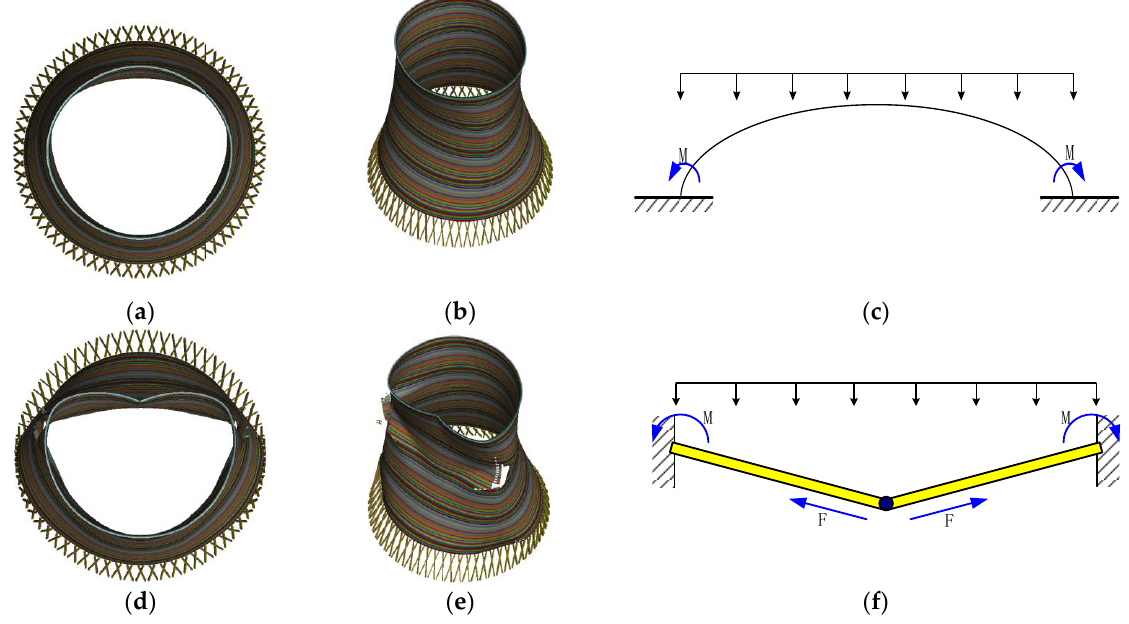
Figure 22. Schematic diagrams of the cooling tower collapse mechanism and mechanical model. ( a ) Top view of the bending arch mechanism. ( b ) Overview of the bending arch mechanism. ( c ) Mechanical model of bending arch mechanism. ( d ) Top view of suspended wire mechanism. ( e ) Overview of suspension wire mechanism. ( f ) Mechanical model of suspension wire mechanism.